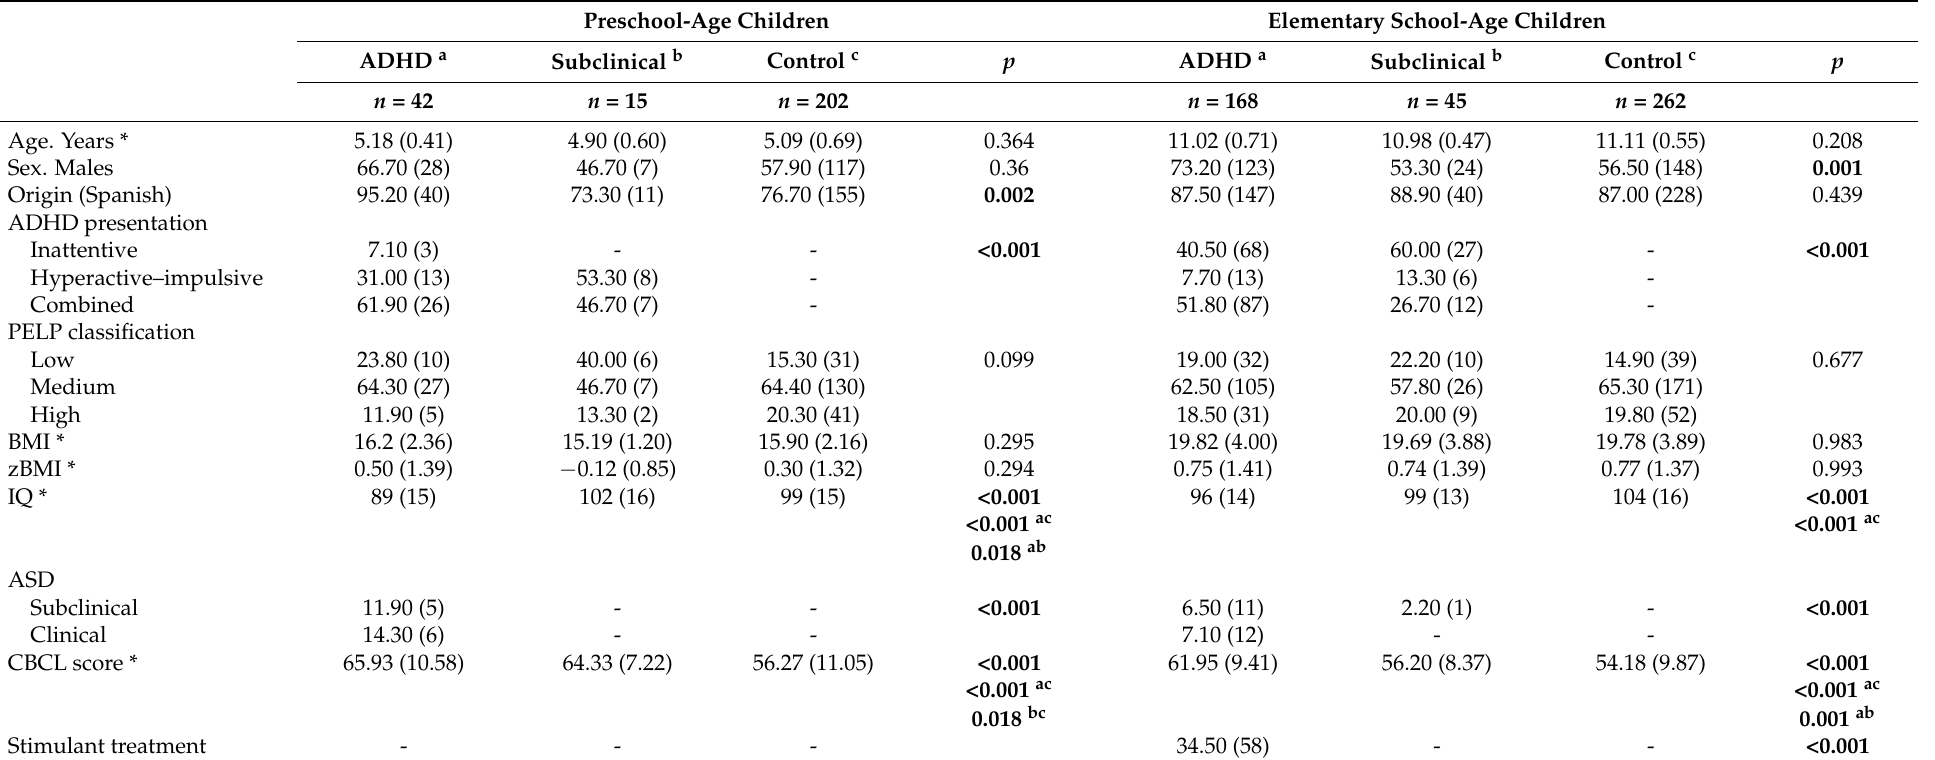
Table 1. Sociodemographic, psychological, nutritional, and anthropometric characteristics per age group and ADHD